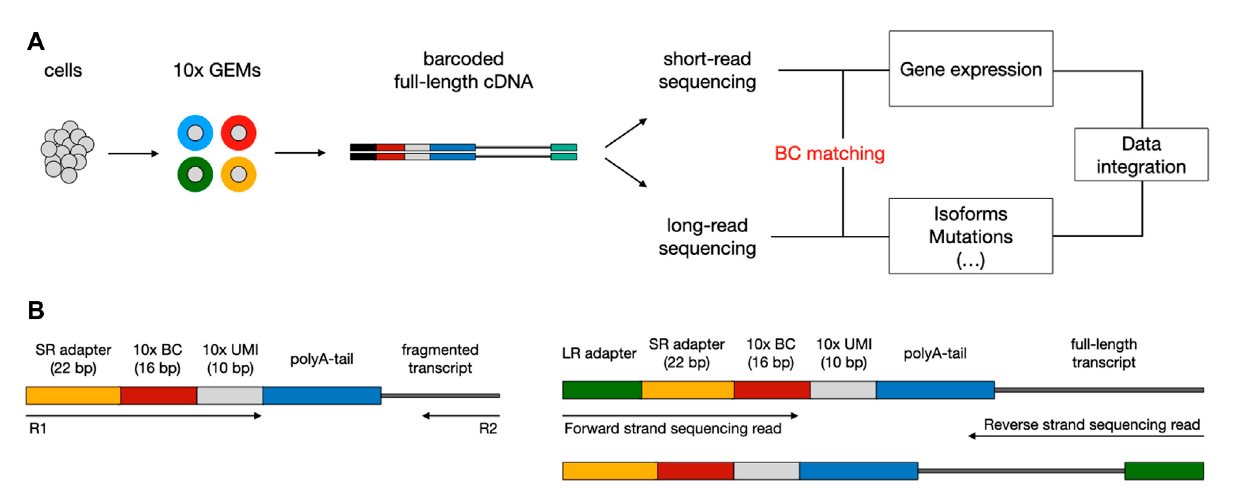
FIGURE 1 Typical work fl ow to couple short-read with long-read scRNA-seq using the 10x Chromium platform. (A) Overview of library preparation, sequencing, and downstream analysis. Single cells are captured into Gel Beads-in-emulsion (GEMs) through a micro fl uidic chip. Inside the GEMs, poly- adenylated mRNA transcripts undergo tagging with a cellular barcode (BC) and unique molecular identi fi er (UMI), followed by reverse transcription for full-length cDNA production. After the GEMs are broken, cDNA can be split between short-read (SR) and long-read (LR) sequencing. During downstream analysis, shared BCsareused tolinkSR andLRdata,enablingtheintegrationofmultiomics information. (B) Structure ofreadtemplates. The SRtemplate(left)consistsofpoly-adenylatedfragmentedtranscriptsattachedtoanIlluminaadapter,BC,andUMIof fi xedlength,ina fi xedsequence.The LR template (right) is essentially the same as the SR template but for the addition of the LR sequencing adapter and length of the